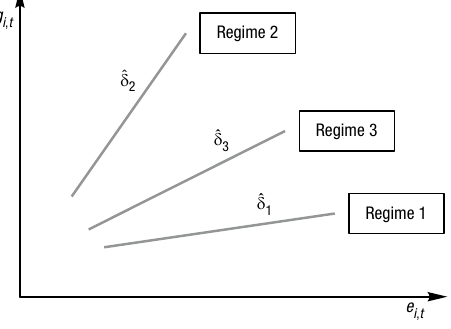
Fig. 7. The long-term hedge coefficients in three